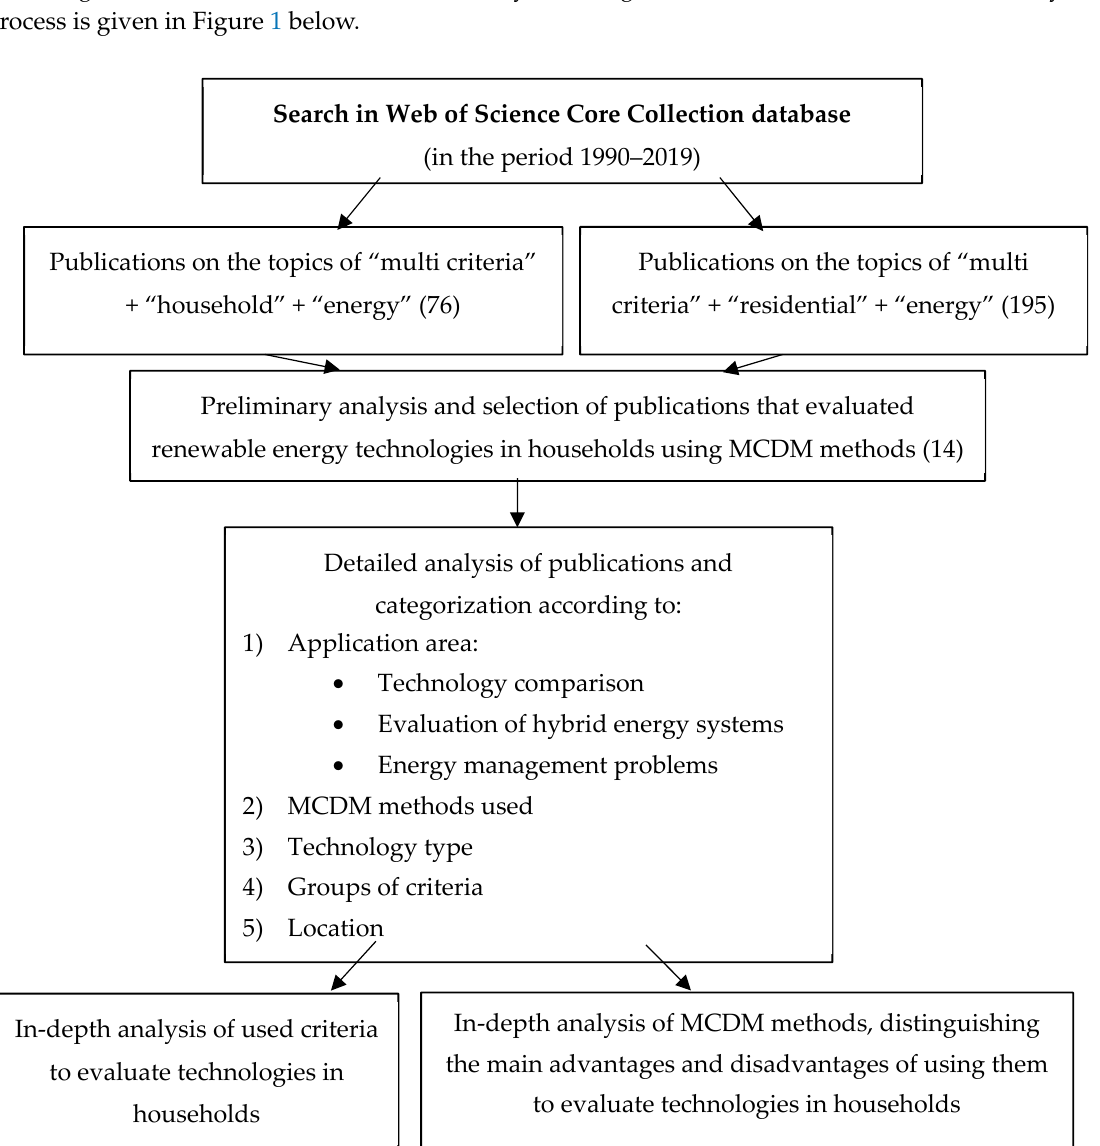
Figure 1. The procedure used for the literature review analysis.